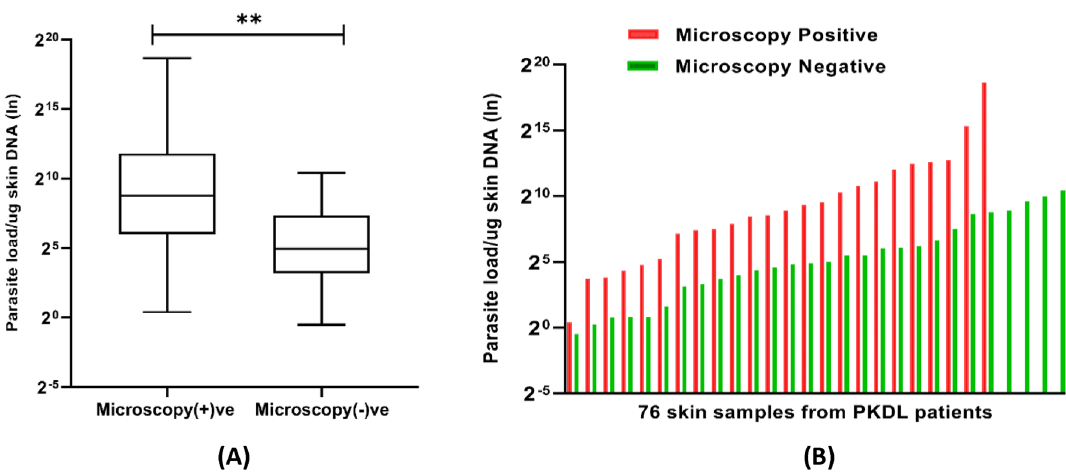
Figure 4. ( A ) Difference in parasite loads between microscopy positive and negative cases. ( B ) Distribution of parasite loads among microscopy positive and negative